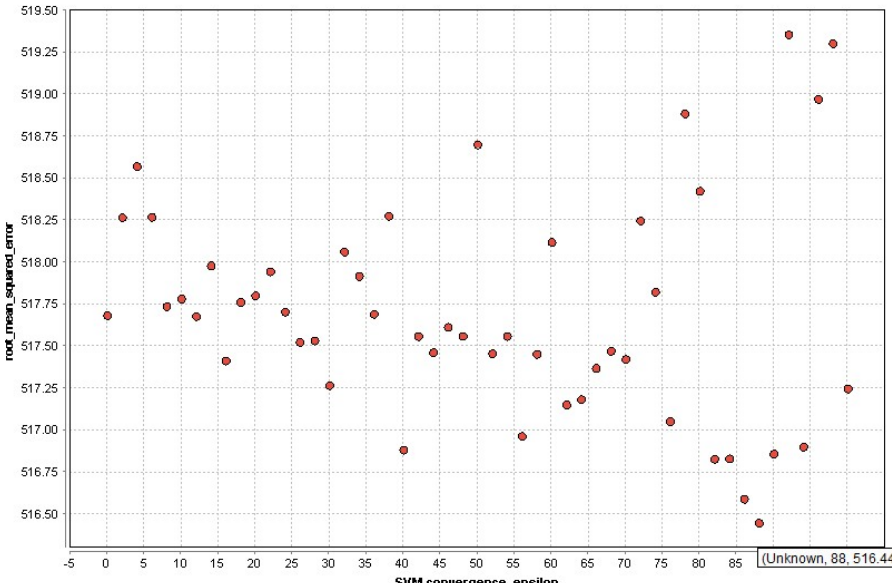
Figure 12. Convergence epsilon tuning results for SVM model.